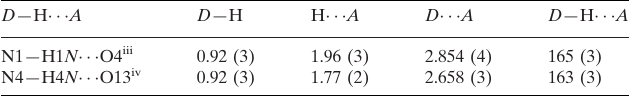
Hydrogen-bond geometry (A˚ , (cid:4)